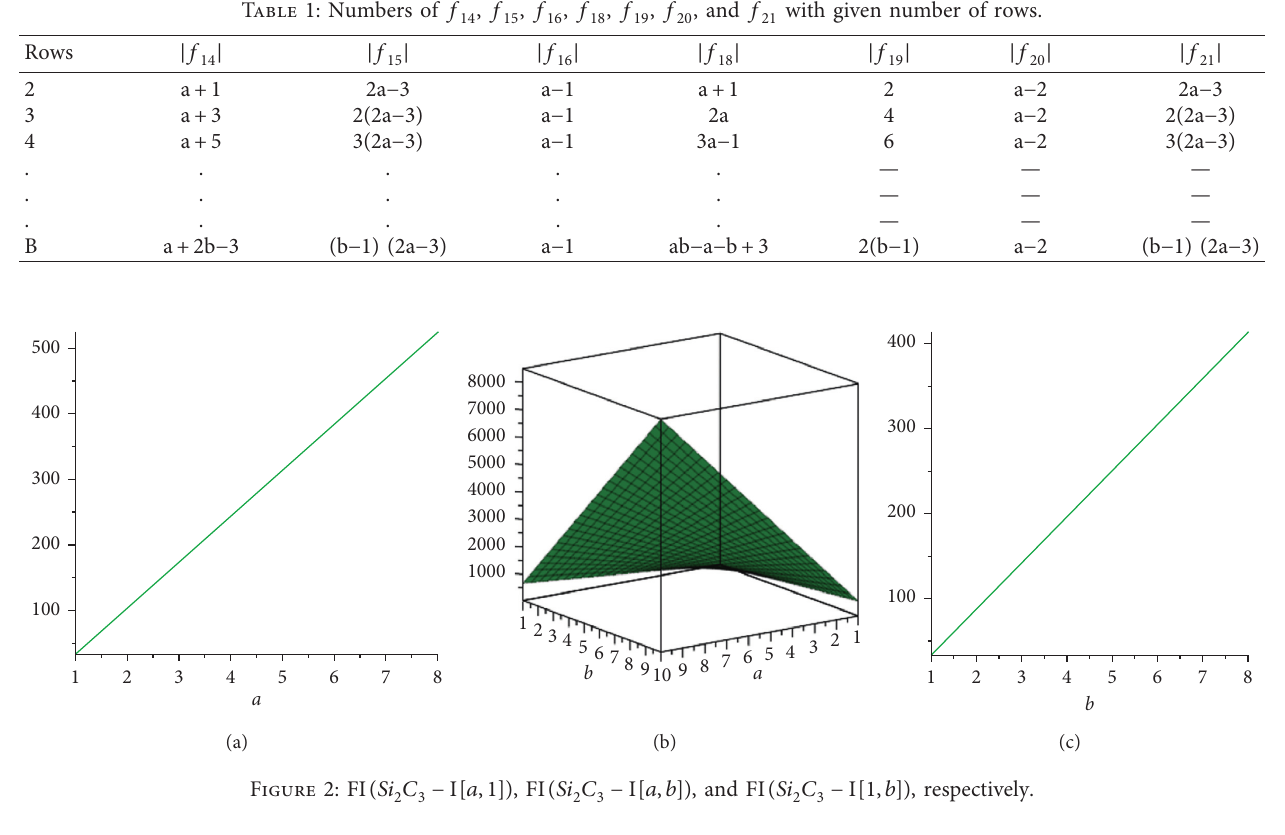
Table 1: Numbers of f